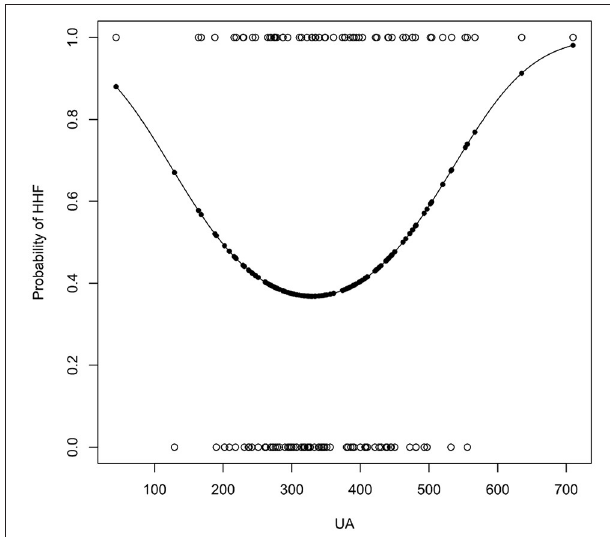
FIGURE 2 | The result of univariate logistic regression of UA. The x-axis is the concentration of uric acid ( µ mol/L).